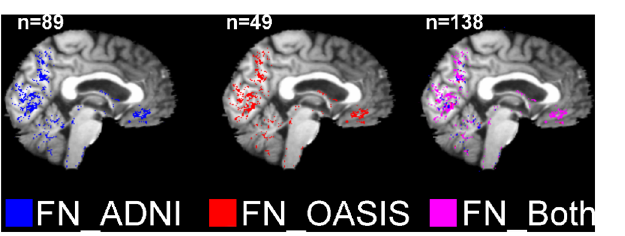
Fig 10. Locations of “ normal P , abnormal NP ” (FN) voxels in Alzheimer ’ s disease (AD) subjects (aged 60 – 90 years) from ANDI (n = 89) and OASIS (n = 49). These were determined via voxel assessment with the parametric (mean ± SD) and nonparametric (order-based) grey matter atlases; P = parametric; NP = nonparametric; ADNI = Alzheimer ’ s Disease Neuroimaging Initiative; OASIS = Open Access Series of Imaging Studies.